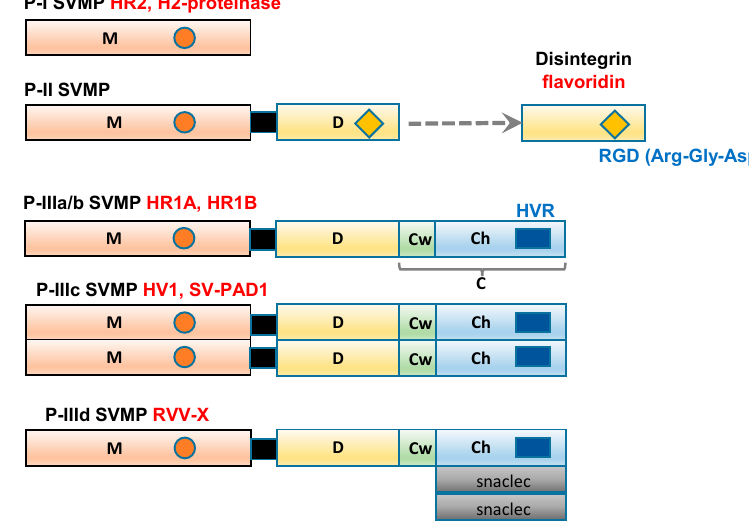
Figure 1. Schematic diagram of the domain structures of P-I, P-II, and P-III SVMP Each domain or subdomain is represented by a different color. M: metalloprotease domain (orange); D: disintegrin domain (yellow); C: cysteine-rich domain; Cw: the cysteine-rich “wrist” subdomain (light green); Ch: the cysteine-rich “hand” subdomain (light blue); HVR: hypervariable region (dark blue); snaclec: snake venom C-type lectin-like domain (grey).